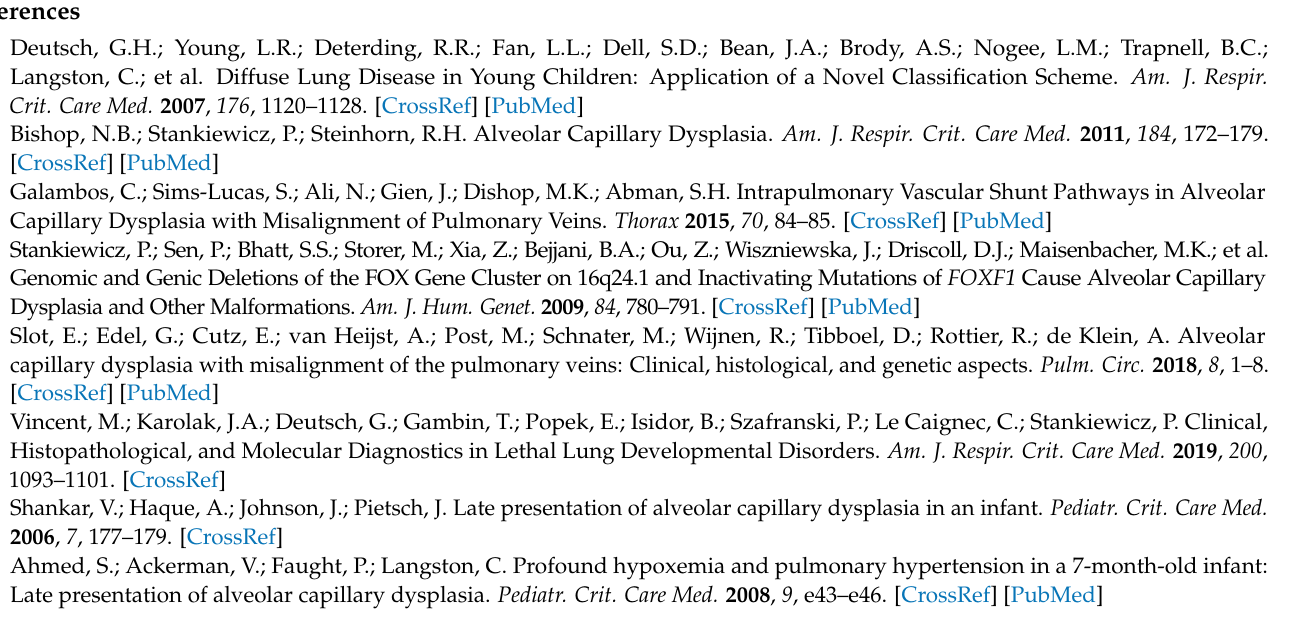
results showing the junction site. Table S1: List of identified informative single-nucleotide variants within the copy-number variant deletion region, showing that it involves maternal chromosome